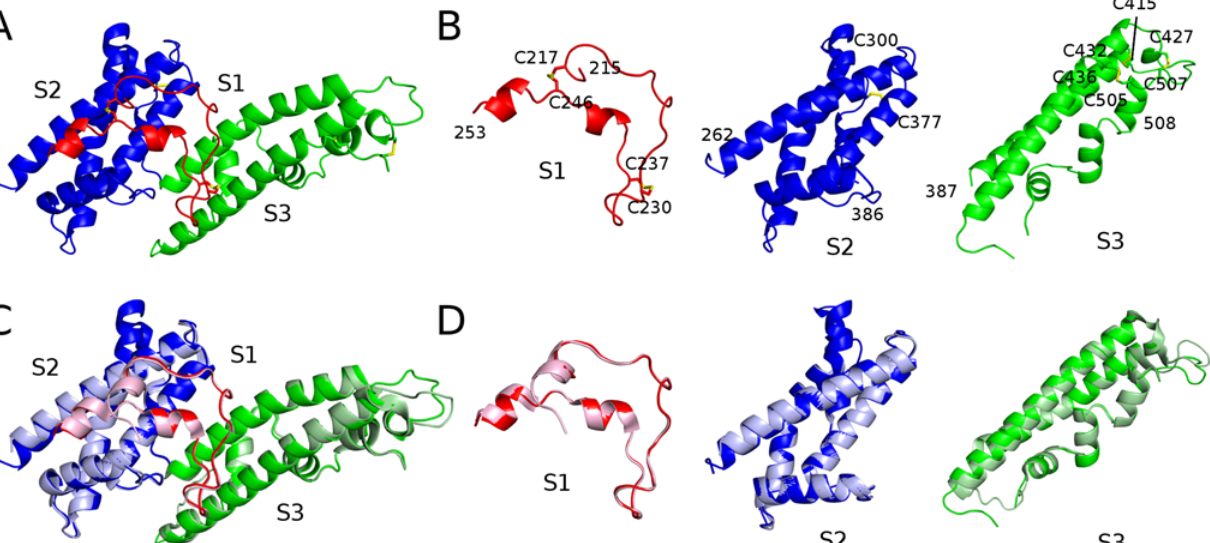
Fig 2. DEKnull is structurally similar to Sal1 DBP-II. (A) DEKnull separated into three sub-domains, sub-domain 1 (S1 — red), sub-domain 2 (S2 — blue), and sub-domain 3 (S3 — green). (B) S1 (red) contains a β -hairpin, S2 (blue) is a helix bundle, and S3 (green) is a helix bundle. Domain boundaries and disulfide bonding cysteines are labeled. (C) Structural alignment of DEKnull (solid colors) with Sal1 DBP-II (light tinted colors) with r.m.s. deviation of 0.435 Å . (D) Structural alignment of individual DEKnull sub-domains (solid colors) with Sal1 DBP-II sub-domains (light tinted colors). S1 alignment has a r.m.s. deviation of 0.308 Å . S2 alignment has a r.m.s. deviation of 0.288 Å . S3 alignment has a r.m.s. deviation of 0.310 Å .